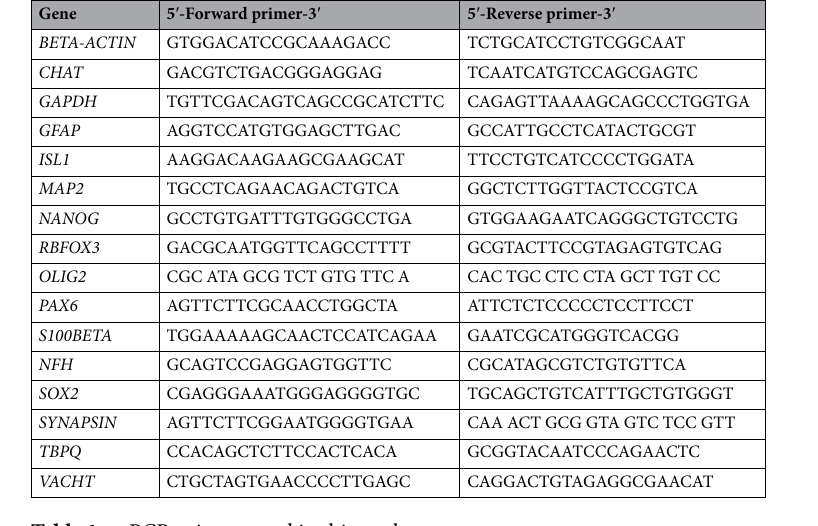
Table 1. qPCR primers used in this study.